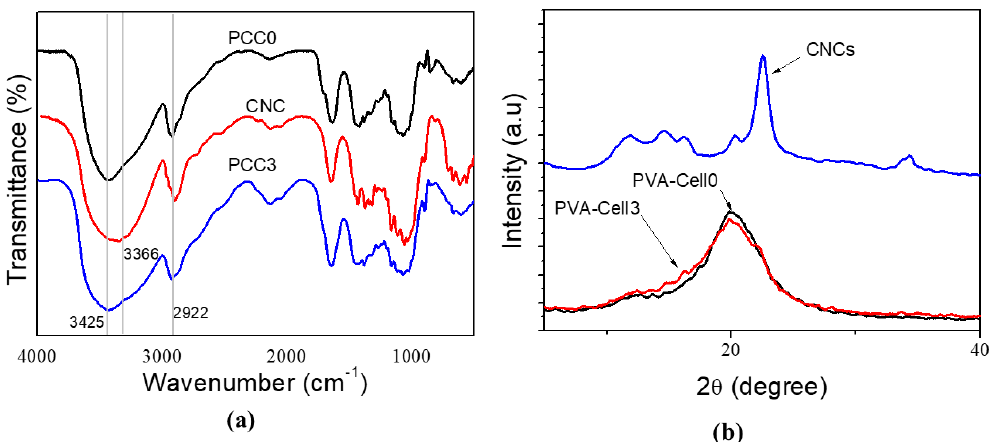
Figure 2. Spectral analysis of CNC, PVA-Cell (PCC0), and PCC3 hydrogels: ( a ) FTIR spectra; ( b ) X-ray diffraction.